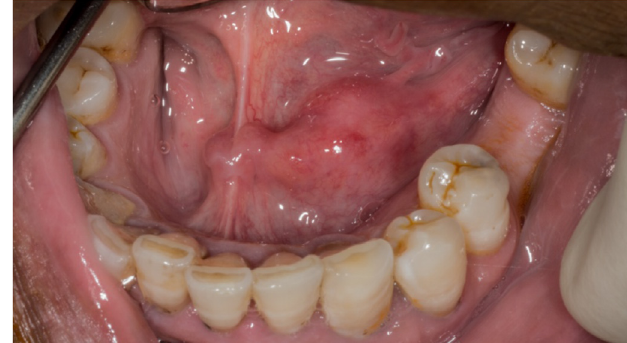
Fig. 5. Clinical view of a congestive ostium of Wharton ’ s duct.